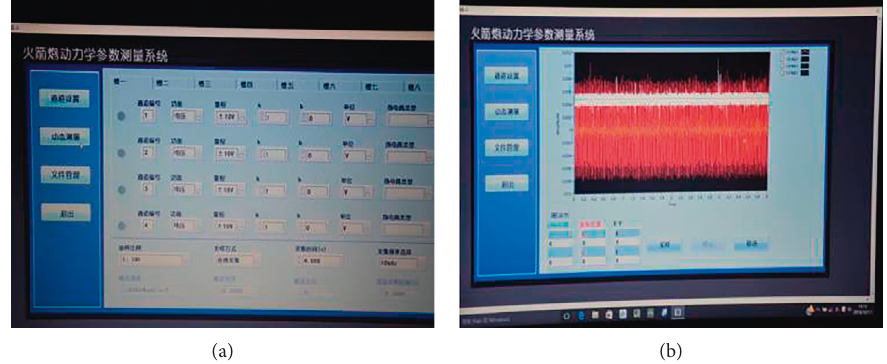
Figure 12: Rocket gun dynamic parameter measurement system.